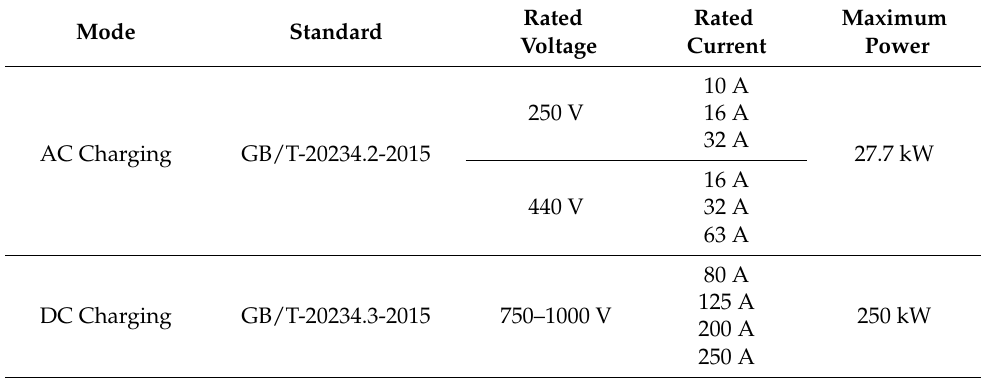
Table 6. Charging classification of the GB/T-20234